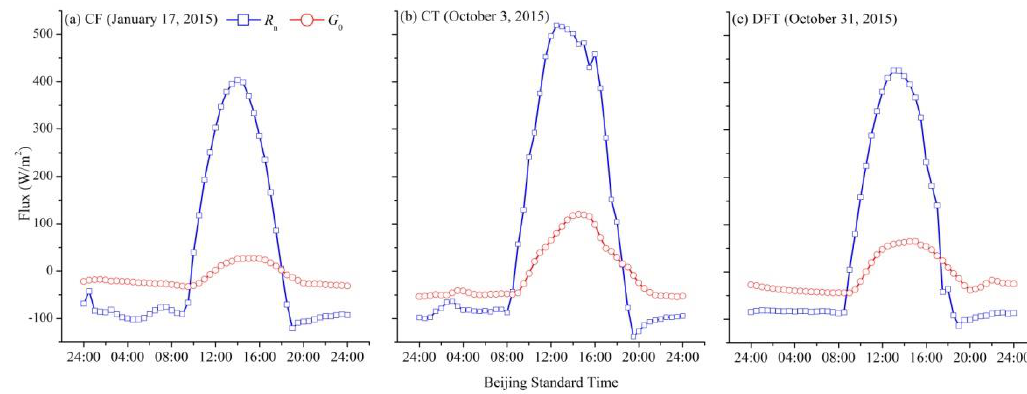
Figure 10. Schematic diagram of the phase shift between ground surface soil heat flux ( G 0 ) and net radiation ( R n ) at site TGLMS during ( a ) complete freezing (CF), ( b ) complete thawing (CT), and ( c ) the daily freeze-thaw cycle (DFT) of a freeze-thaw process.